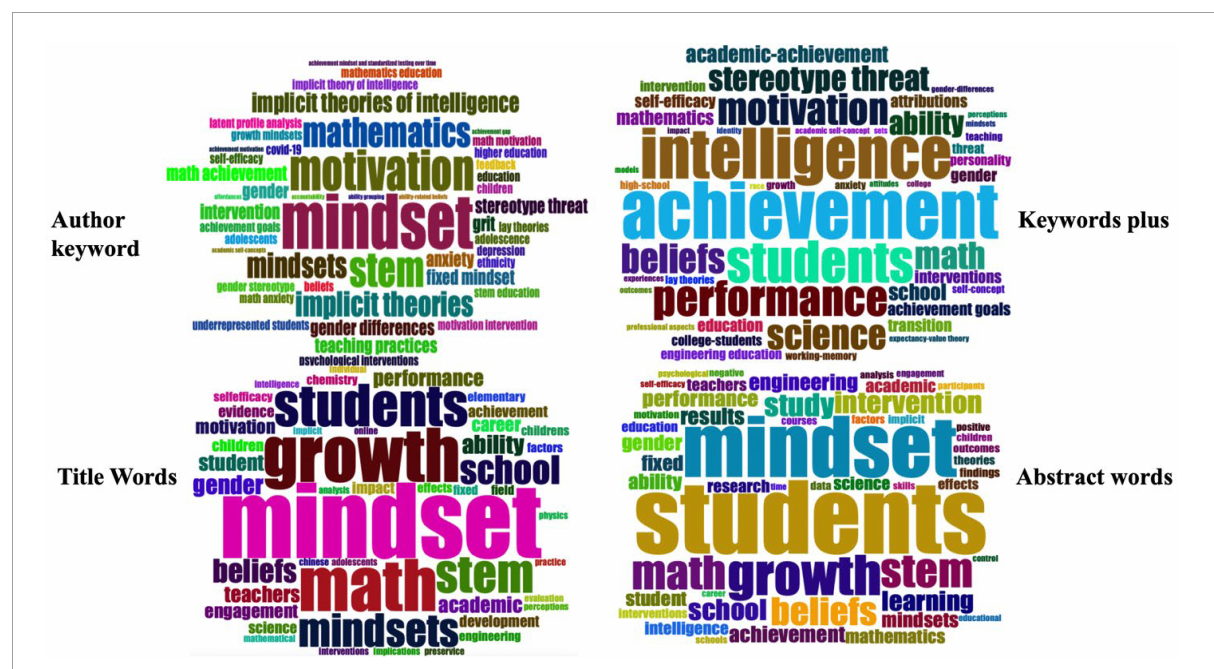
FIGURE7 Clockwise from (top left) : word clouds representing author keywords, "Keywords Plus” phrases, words in abstracts, and words in titles.